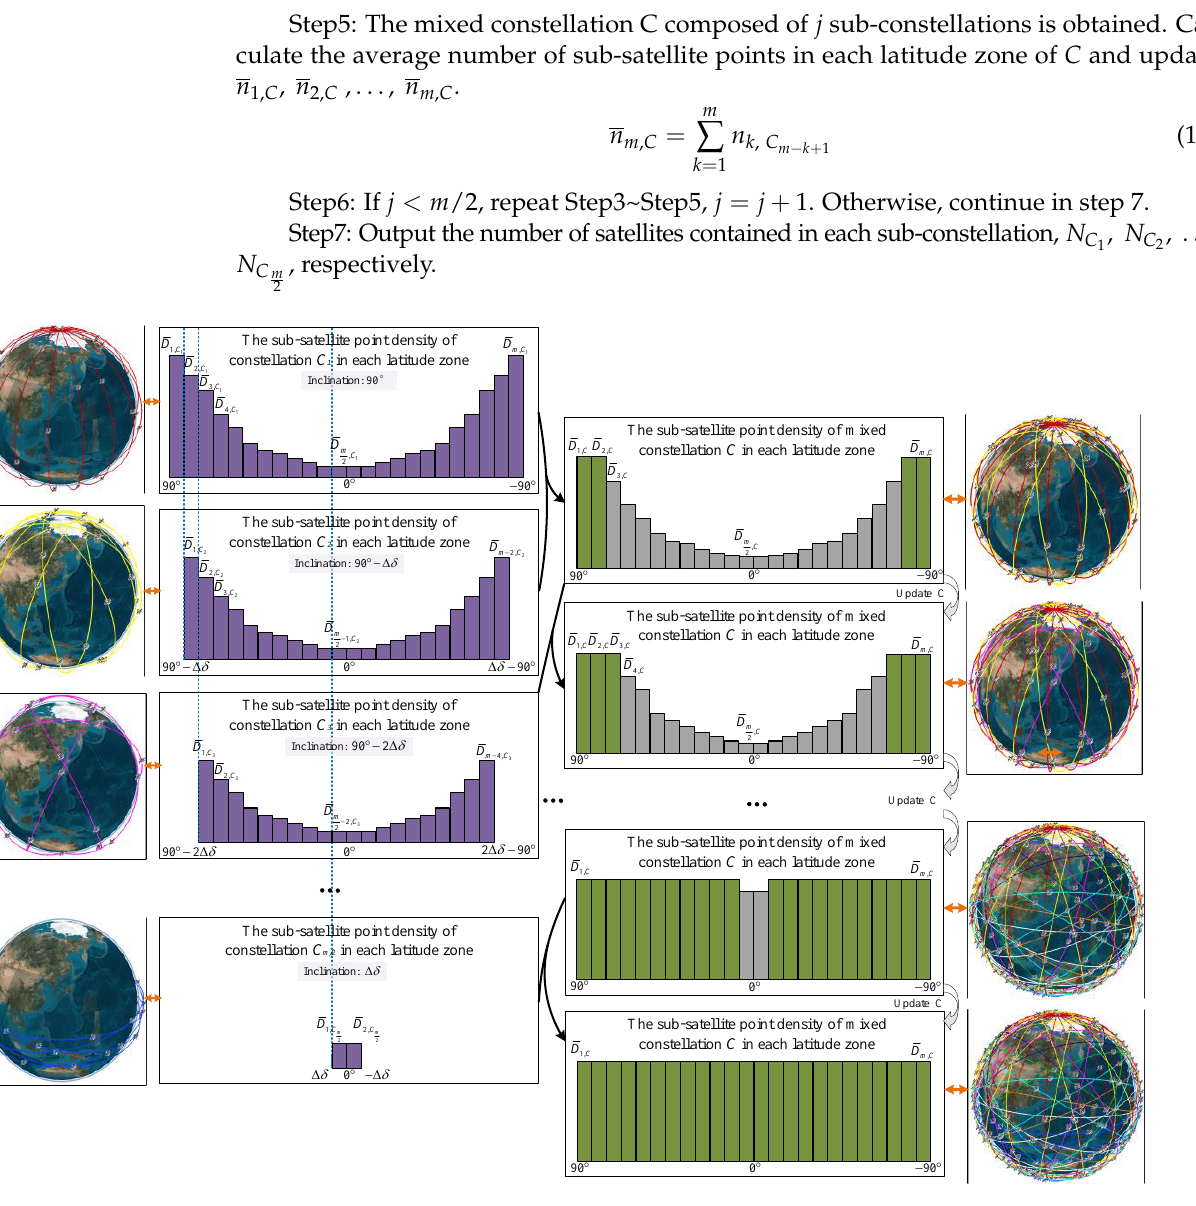
Figure 2. Schematic diagram of sub-constellation generation according to the sub-satellite point density of constellation in iterative order. The configuration of a Walker constellation depends on the three parameters ( N , P , and F ). Through the above steps, we obtain the N of all sub-constellations in the mixed Walker constellation and ensure that the sub-satellite points of the mega-constellation are